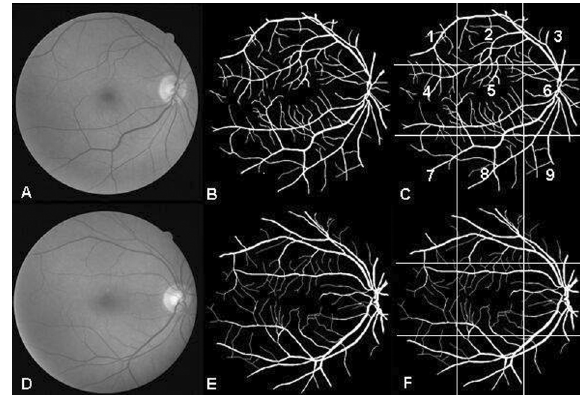
Figure 1. Retinography of normal (A) and mild non-proliferative diabetic retinopathy (NPDR) patients (D). The segmented image of control patients (B) and of patients with NPDR (E) was divided into nine anatomical regions (C,F): nasal superior (1), superior (2), superotemporal (3), optic disc (4), macular (5), temporal (6), nasal inferior (7), inferior (8), and inferotemporal (9). Panels B , C , E , and F are images with black fundus and white vessels, in which it is not possible to differentiate the control from the mild NPDR images with the naked